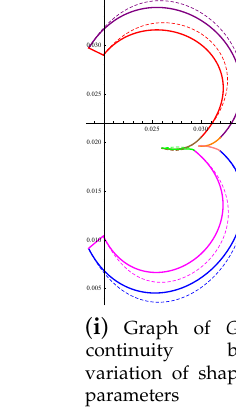
Figure 15. Modeling of complex figures by G 1 , G 2 , and G 3 smooth continuity, respectively, of GHT-Bézier curves with multiple shape parameters. ( a ) Joints by G 1 continuity; ( b ) connected graph of G 1 continuity; ( c ) connected graph of G 1 continuity by varying shape parameters; ( d ) joints by G 2 continuity; ( e ) connected graph by G 2 continuity; ( f ) graph of G 2 continuity by variation of shape parameters; ( g ) joints by G 3 continuity; ( h ) connected graph of G 3 continuity; ( i ) graph of G 3 continuity by variation of shape parameters.